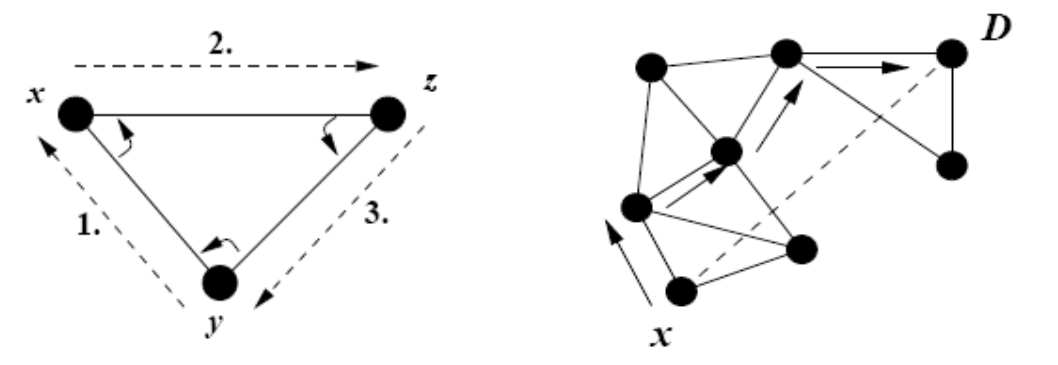
Figure 24. Forwarding path based on GPSR